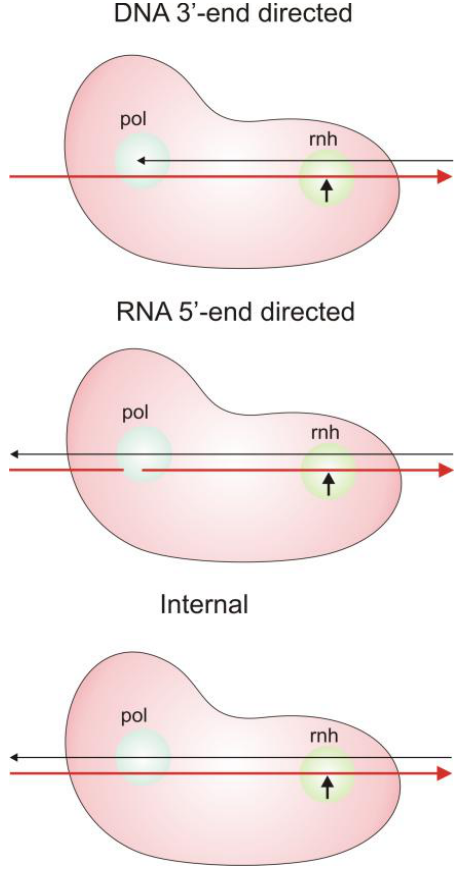
Figure 5. Modes of RT RNase H cleavages. The DNA strand of the nucleic acid duplex is black and the RNA strand is red. Details are provided in the text. Figure adapted from